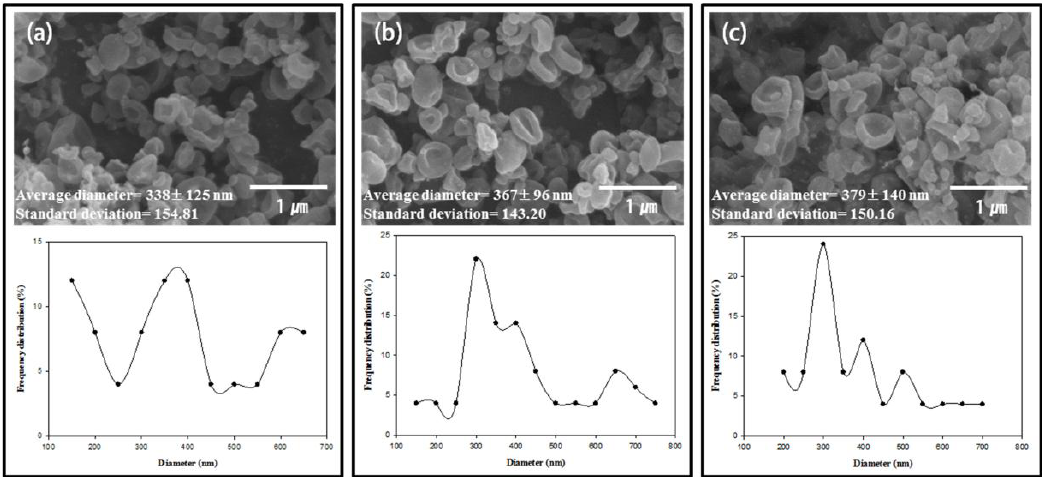
Figure 2. FE-SEM images, average diameter, and distribution of zein/Ag nanoparticles electrospun from ethanol aqueous solutions with an ethanol/water ratio of 8/2 ( v / v ) at Ag concentrations of ( a ) 0, ( b ) 2 and ( c ) 4 wt % (polymer concentration = 10 wt %, TCD = 15 cm, and applied voltage = 15 kV).